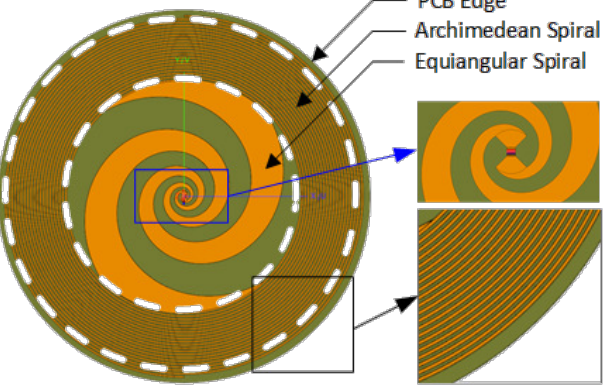
Figure 2. Planar view of the compound-spiral antenna structure. Enlarged views show in greater detail the balanced antenna port ( top inset) and the fine structure of the outer Archimedean spiral ( bottom